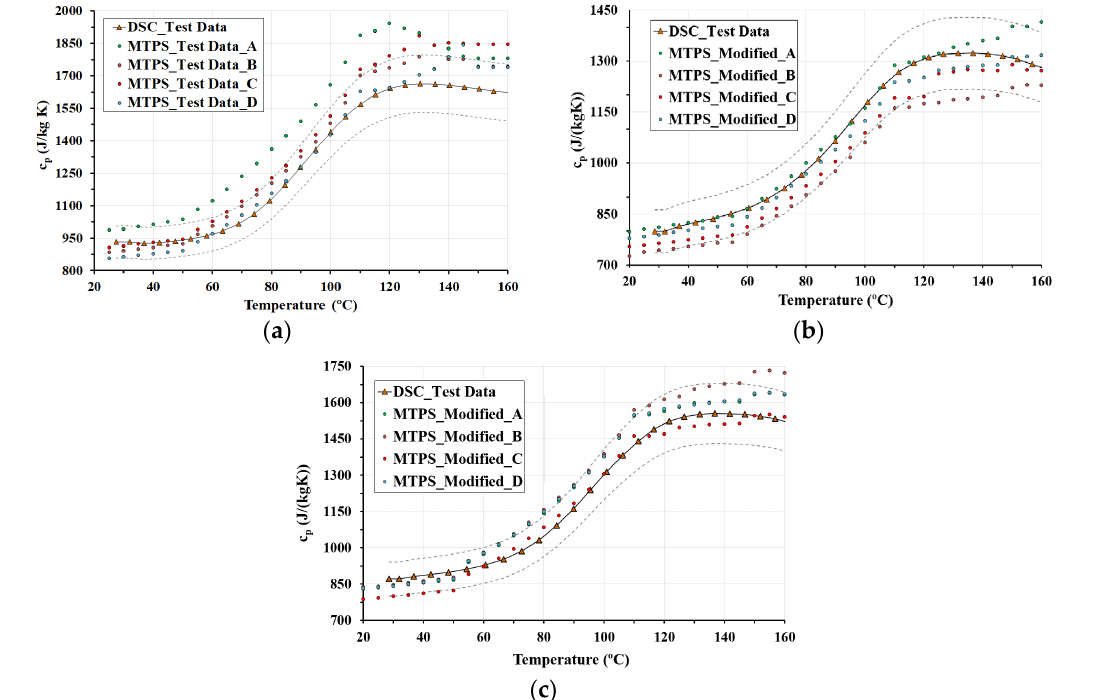
Figure 8. Comparison of specific heat results between 20 and 300 °C: ( a ) LWC-1; ( b ) LWC-2; ( c ) LWC-3.